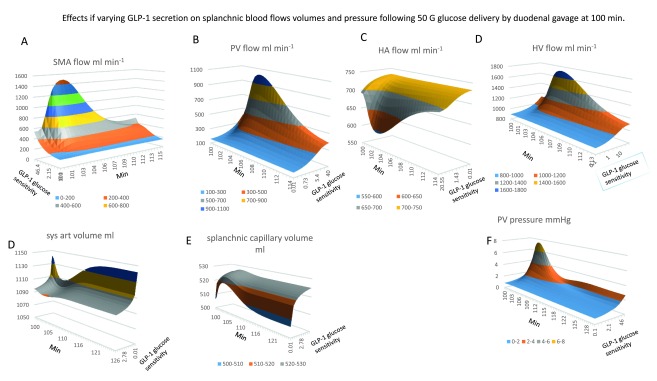
Effects of varying the glucose sensitivity of GLP-1 secretion on splanchnic blood flows, volumes and pressure following 50 G glucose delivery by duodenal gavage at 100min.All the graphs are contoured surface plots in which the
x axis is the time coordinate, the
y axis is the GLP-1 sensitivity to glucose – this generates GLP-1at a rate proportional to the sensitivity and splanchnic blood glucose concentration, (Figure 1B GLP-1equations 1). With low GLP-1secretion the changes in glucose sensitive blood flow are reduced.
Panel A The effects of GLP-1sensitivity and time on SMA flow. There GLP-1dependent increase in SMA flow response to glucose gavage peaks 3–6 min after glucose gavage and is sustained for 15–20min (
K
½GLP-1 sens. = 12; maximal flow rate 1500 ml min
-1; maximal flow rate 1500 ml min
-1).
Panel B Portal venous flow ml min
-1 versus GLP-1sensitivity and time. The graph has a similar GLP-1sensitivity and time course to SMA in (
Panel A). PV flow rises hyperbolically with GLP-1sensitivity
K
½GLP-1 sens. = 12; maximal flow rate 1100 ml min
-1.

Panel C, the effects of GLP-1sensitivity and time after gavage on hepatic artery HA flow. The high GLP-1sensitivity is shown at front of the
y scale. HA flows fall simultaneously with the rise in PV flow. This is due to the decreased aortic pressure and volume (
Panel D) resulting from the enlargement of the splanchnic volume (
Panel E).
Panel F Effects of glucose sensitivity GLP-1secretion on portal venous PV pressure changes after glucose gavage. The rise in pressure mirrors the changes in PV flow (
Panel B) and SMA flow (
Panel A), (
peak PV pressure is approximately 8mm Hg; K
½GLP-1 sens. = 15).